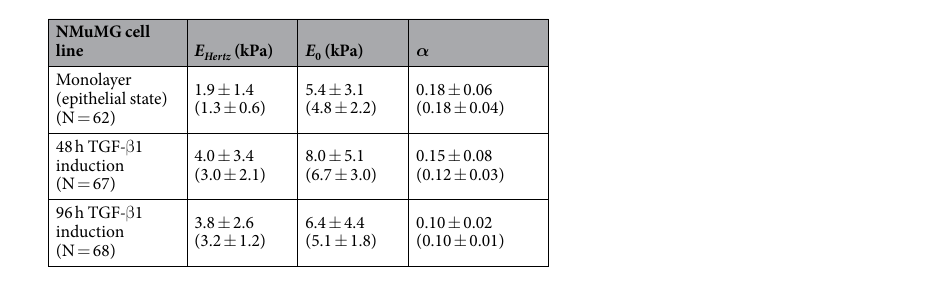
Table 3. Viscoelastic parameters of NMuMG cells before and during EMT. N is the number of measured cells. Mean ± s.d. (median ±